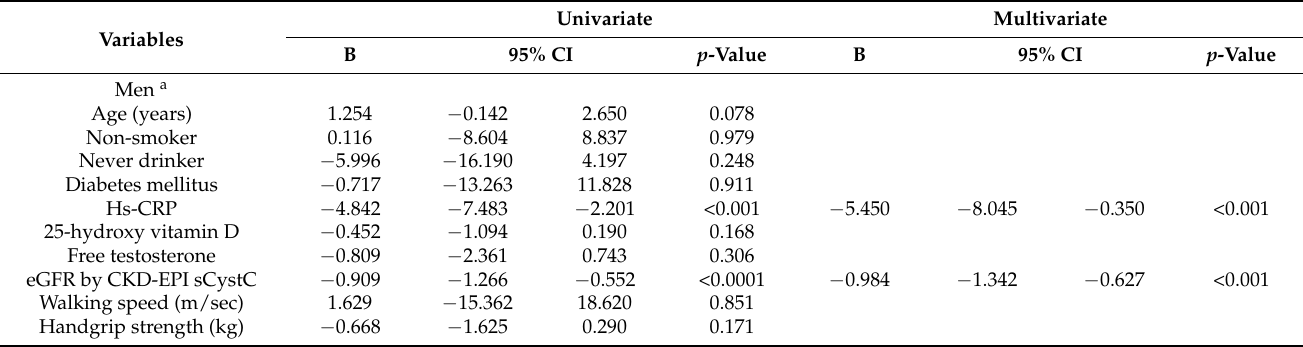
Table 4. Simple and multiple linear regression analyses for serum myostatin/ASM ratio in 519 men and 534